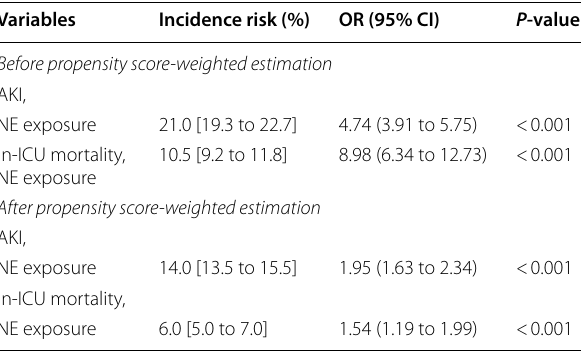
Table 4 Incidence risk for acute kidney injury (AKI) and in‑ICU mortality according to exposure to norepinephrine (NE)